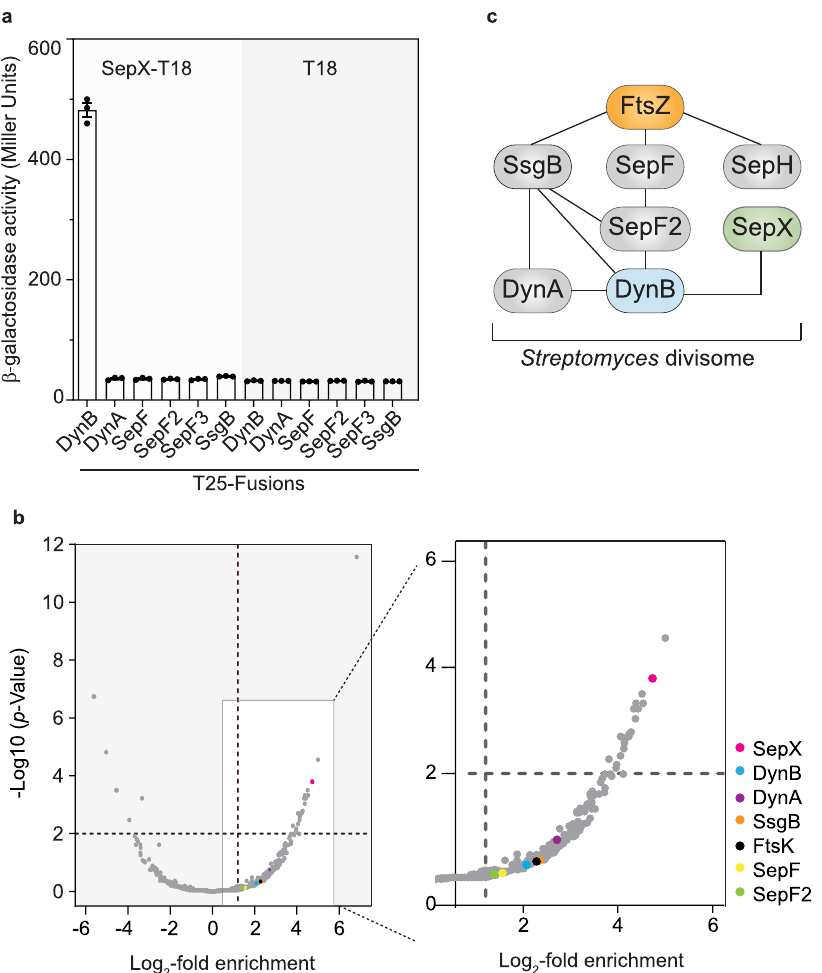
Fig. 5 SepX is part of the S. venezuelae divisome and speci fi cally interacts with DynB. a Bacterial two-hybrid analysis and corresponding β -galactosidase activities between SepX-T18 or the empty plasmid (T18) and the indicated T25-fusions. Data points present mean values ± s.e.m. Each interaction was assayed in biological triplicate. b Co-immunoprecipitation and mass spectrometry analysis of SepX. Immunoprecipitation experiments were performed using the control strain SS92 ( dynB-ypet ) or a strain expressing a sepX-FLAG / dynB-ypet fusion (MB942) and anti-Flag antibody-conjugated magnetic beads. Proteins that were retained on the beads were analyzed using mass spectrometry. Data obtained from three biological replicate experiments are displayed as a volcano plot (left) with several putative interaction partners highlighted in the enlarged subsection of the plot (right). The complete data set is included in the Source Data. c Schematic showing the proposed SepX interaction network, including DynB and several known S. venezuelae divisome components 11,12